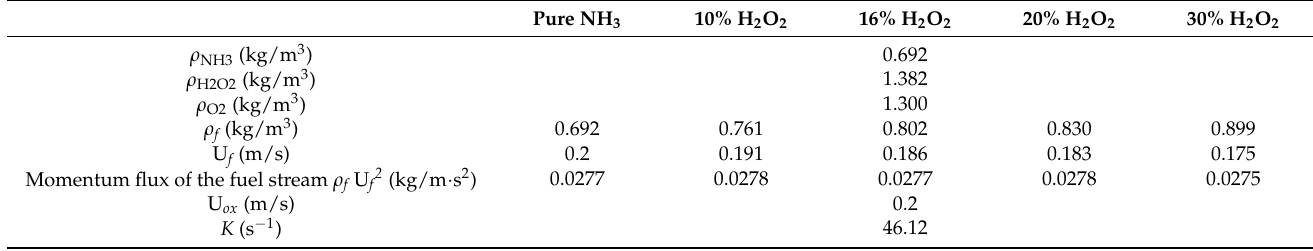
Table 2. Density, velocity, momentum flux, and estimated strain rate at the stoichiometric surface for NH 3 -H 2 O 2 /O 2